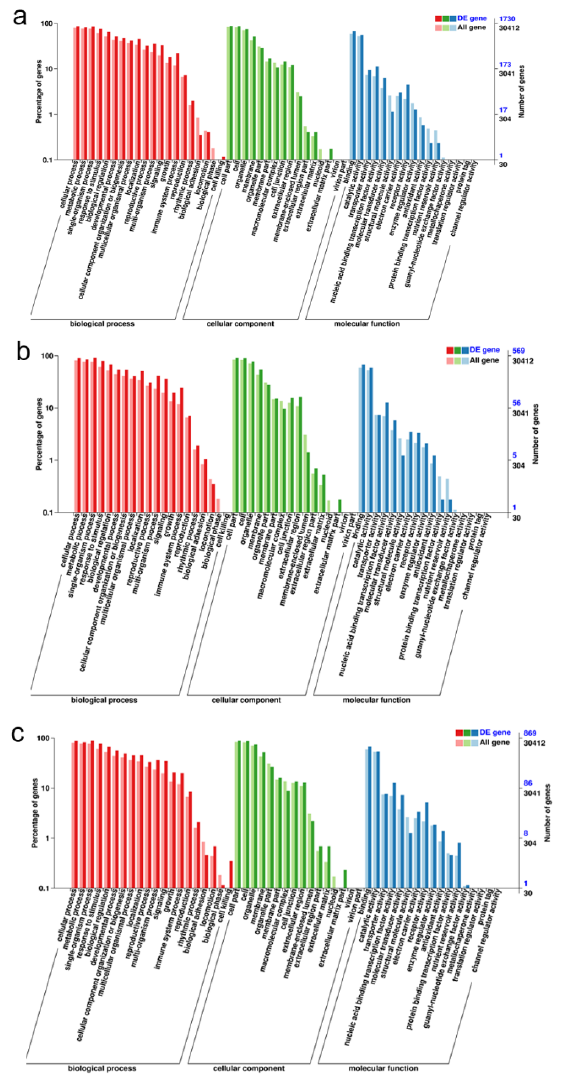
Figure 6. GO classification on the DEGs among CK, T12, and F20 under salt stress treatment. ( a ) GO classification of the DEGs between T01, T02, T03 and T10, T11, T12 samples; ( b ) GO classification of the DEGs between T04, T05, T06 and T13, T14, T15 samples; ( c ) GO classification of the DEGs between T07, T08, T09 and T16, T17, T18 samples. 2.8. KEGG Enrichment on the DEGs among CK, T12, and F20 under Salt Stress Treatment According to the KEGG enrichment analysis, the DEGs between T01, T02, T03 and T10, T11, T12 were mainly involved in plant–pathogen interaction, ribosome biogenesis in eukaryotes, protein processing in endoplasmic reticulum, degradation of aromatic com- pounds, plant hormone signal transduction, photosynthesis, and carbon metabolism pathways (Figure 7a). Most of the DEGs between T04, T05, T06 and T13, T14, T15 were involved in plant–pathogen interaction, selenocompound metabolism, cysteine and me- thionine metabolism, phagosomes, biosynthesis of amino acids, phenylalanine, tyrosine and tryptophan biosynthesis, plant hormone signal transduction, and starch and sucrose metabolism pathways (Figure 7b). Most of the DEGs between T07, T08, T09 and T16, T17,